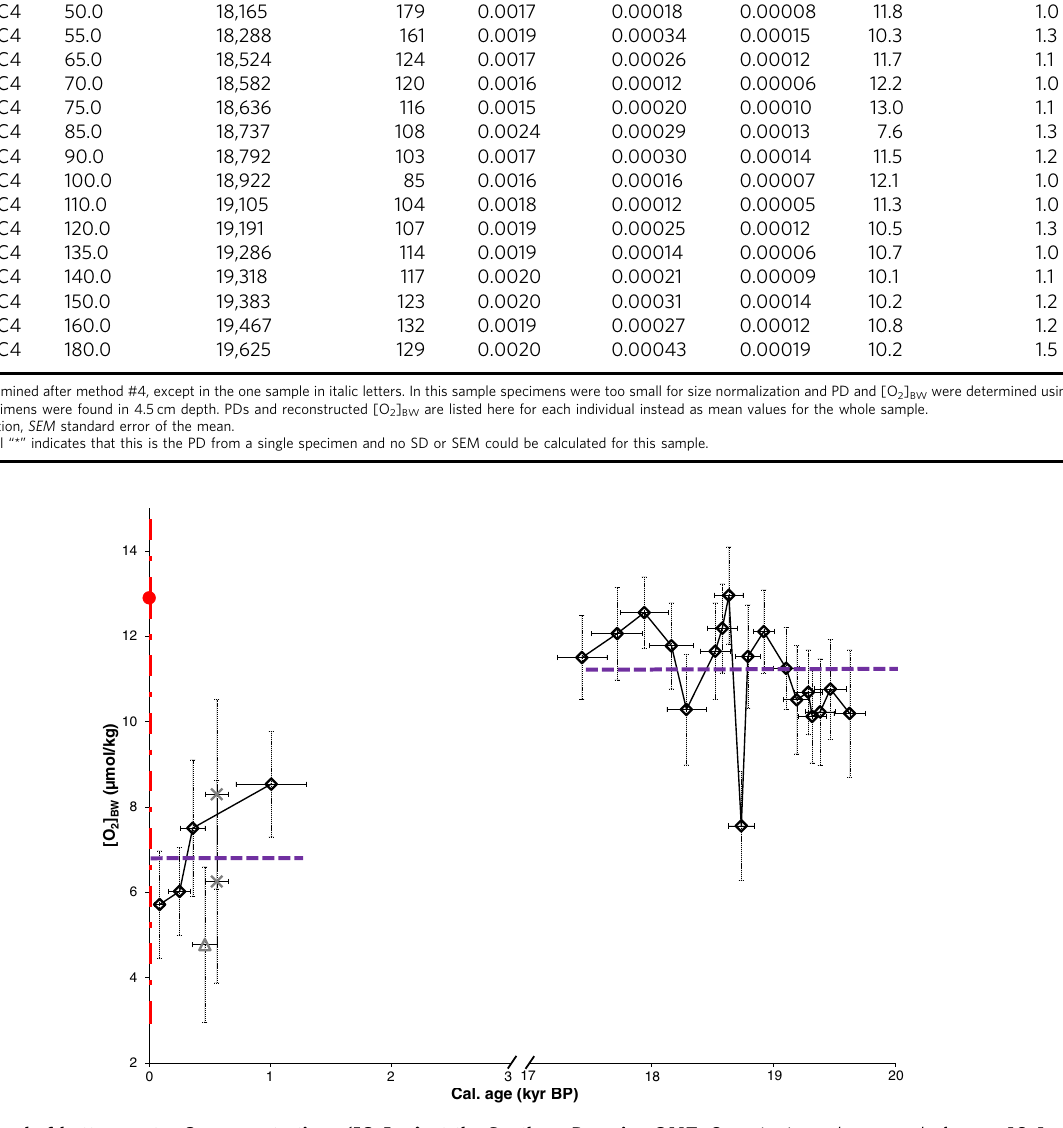
Fig. 5 Paleorecord of bottom water O 2 concentrations ([O 2 ] BW ) at the Southern Peruvian OMZ. Quantitative palaeorecord of mean [O 2 ] BW in cores M77/1 406-MUC6 and M77/1 416-GC4 using the PD of Planulina limbata . The X -axis is broken at 3 kyr BP. Note that the slice during the Late Holocene (LH) is from M77/1 406-MUC6 and the slice from the Last Glacial Maximum (LGM) from core M77/1 416-GC4. All PDs were determined after method #4, except in the one sample plotted as a gray triangle. In this sample specimens were too small for size normalization and PD and [O 2 ] BW were determined using method #3. Since only two specimens were found in one sample each individual reconstructed [O 2 ] BW instead of mean values were plotted as gray crosses. (4.5 cm depth) Horizontal errors are the standard deviation (1 SD) Vertical error bars are standard error of the mean (1 SEM) except for the gray crosses (1 SD). Mean modern [O 2 ] BW in this region is highly variable in this region (range from 1 – 25 µ mol/kg 57 – 60 ). The red dot represents the mean modern [O 2 ] BW (red dashed line = 1 SD). Note that all the reconstructed [O 2 ] BW are within the range of short time modern variability. COMMUNICATIONS EARTH & ENVIRONMENT| (2022) 3:307